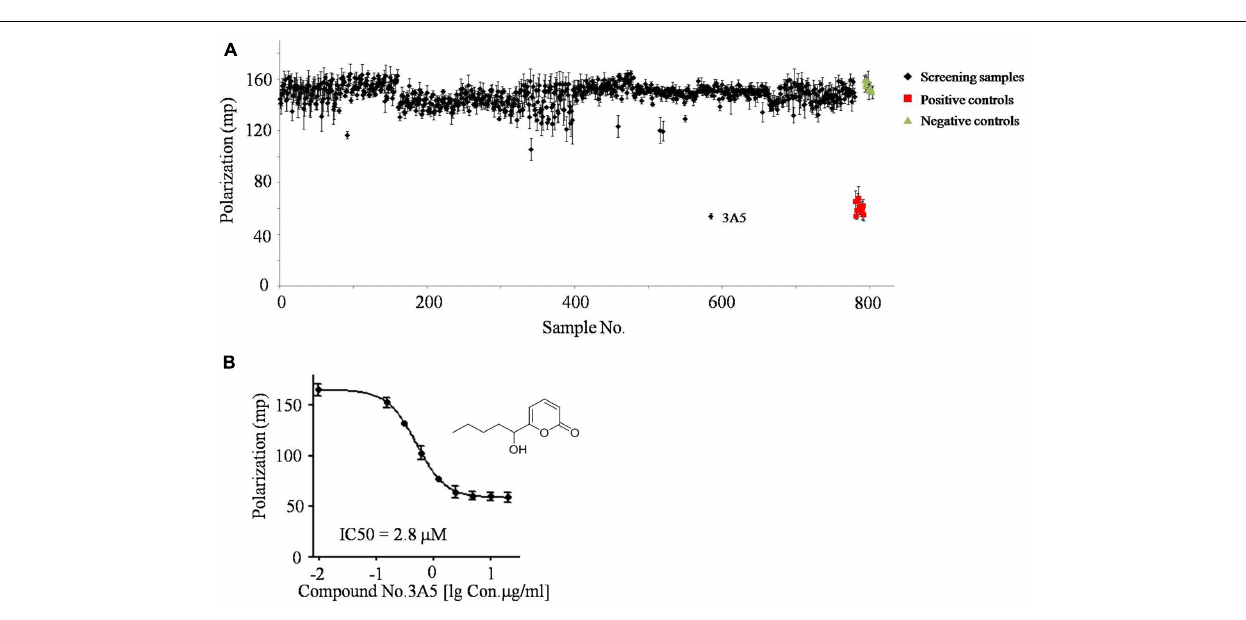
FIGURE 2 | The screening results of FP based ssDNA binding assay. (A) About 800 small molecular compounds and crude extracts were screened using the FP system. (B) IC 50 assay of compound No.3A5 toward the interaction between NS3h and